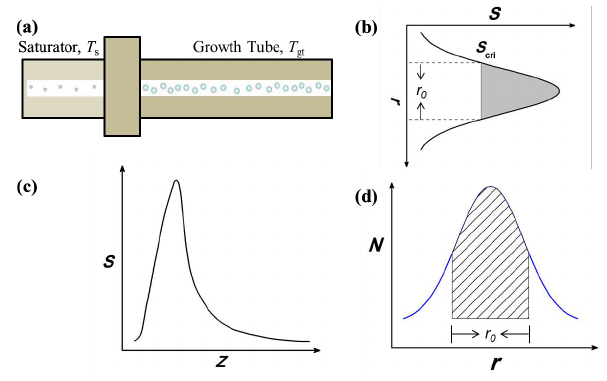
Figure 5. (a) Structure of the water CPC 3788 from TSI; schematic supersaturation S profiles (b) in the radial and (c) streamwise (ac- cording to Kulmala et al., 2007); the gray shadow represents the area where S is larger than the S cri (critical supersaturation); r is the distance from the centerline and Z is the distance from the start- ing point of the growth tube. (d) Radial distribution of activated particles (areas with black lines); blue line is the schematic parti- cle number distribution in the growth tube. The activated areas are determined by the distance along the radials shown in Fig.